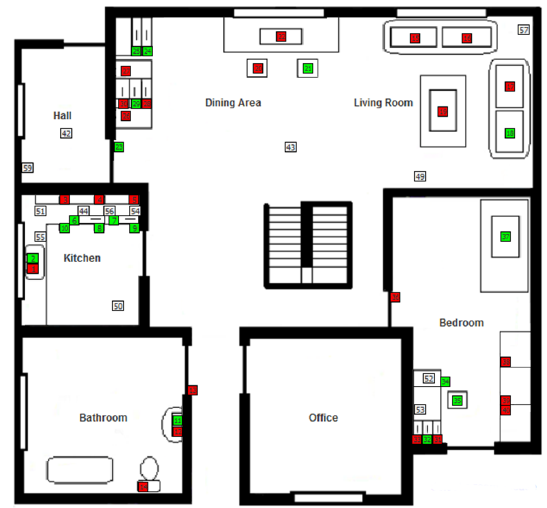
Figure 1: UH Robot House map showing the location of sensors (identified by numbers) and their states with green colour repre- senting the sensor in open/on/free state, red colour representing the sensor in closed/off/occupied state and transparent represent- ing the sensor in a not activated/unknown